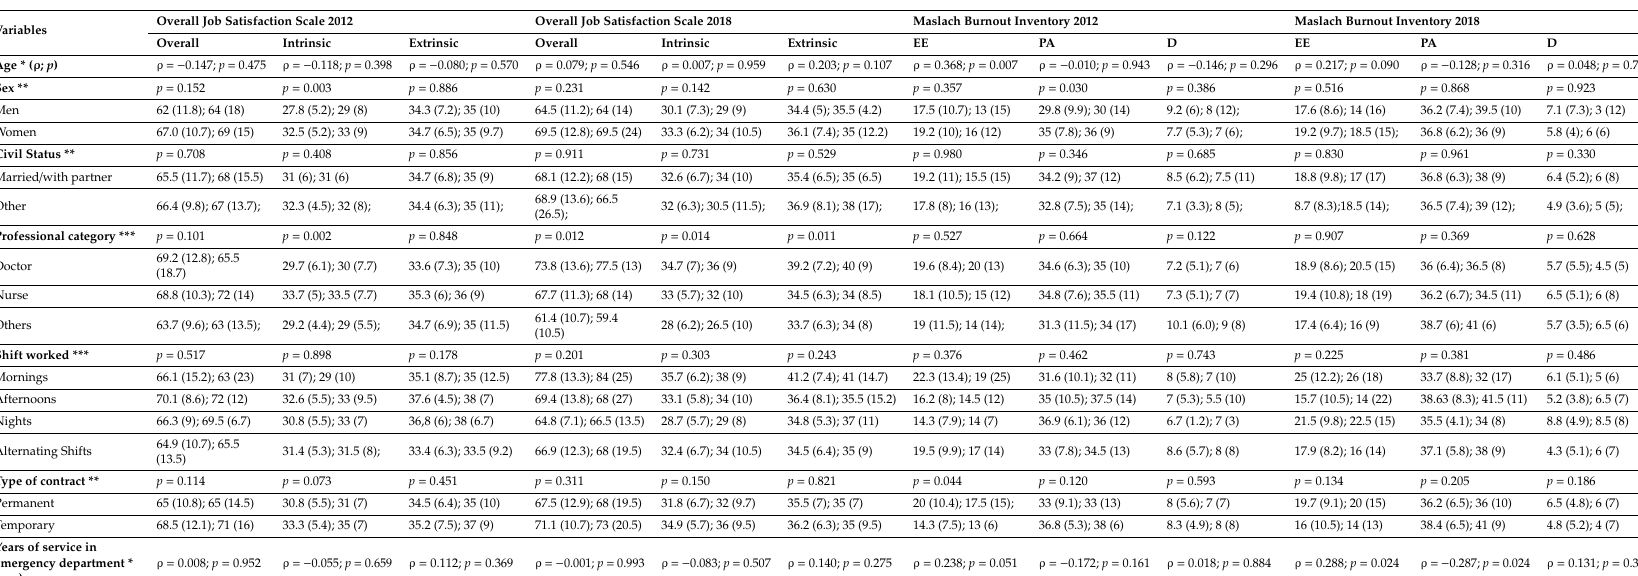
Table 5. Relationship of satisfaction and the Maslach Burnout Inventory in 2012 and 2018 with sociodemographic and occupational